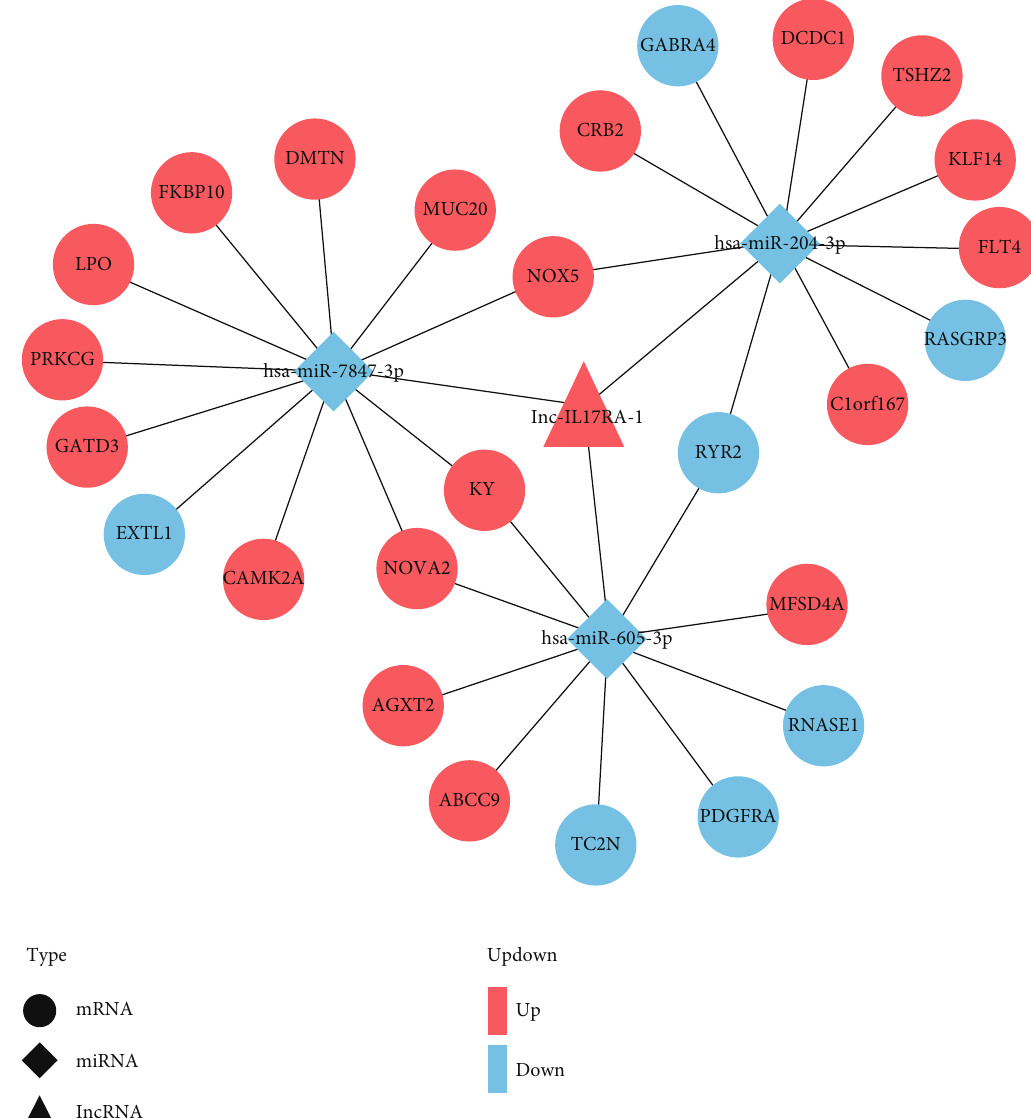
Figure 4: ceRNA network diagram. Triangle represents lncRNA, diamond represents miRNA, and circle represents